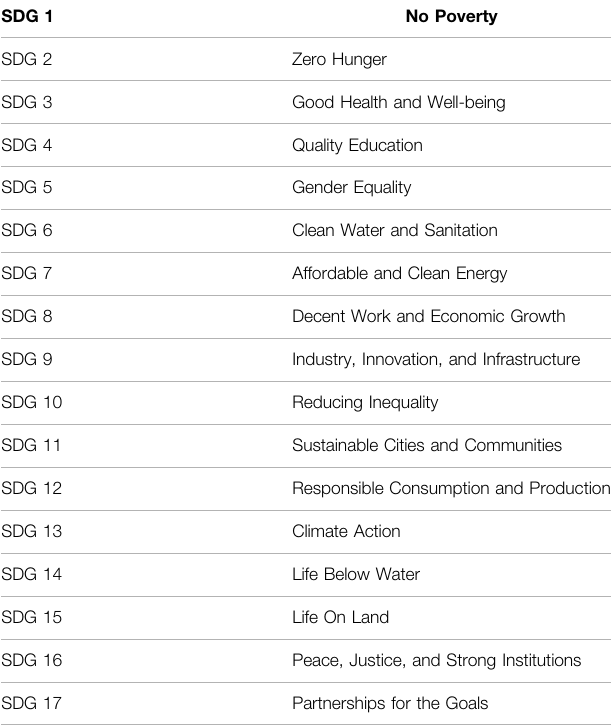
TABLE 1 | List of the